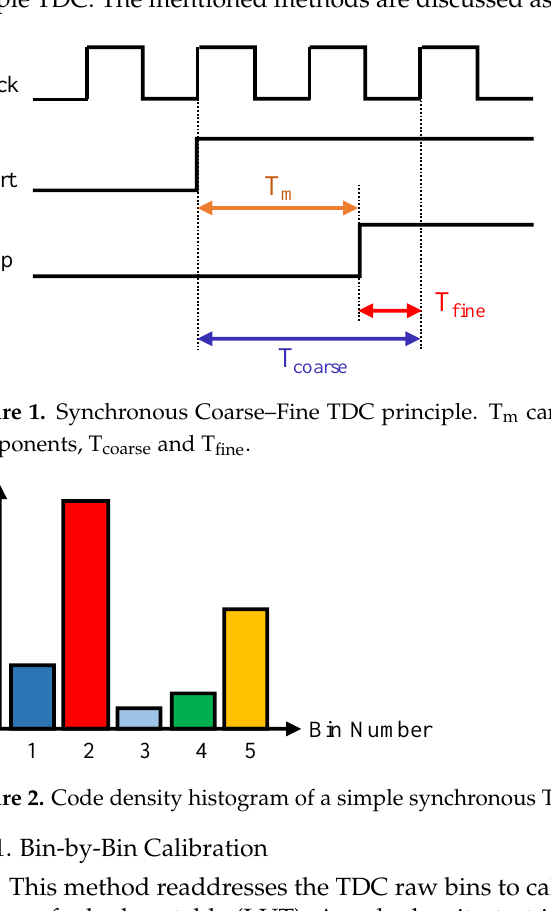
Figure 1. Synchronous Coarse – Fine TDC principle. T m can be measured as a subtraction of two com- ponents, T coarse and T fine .